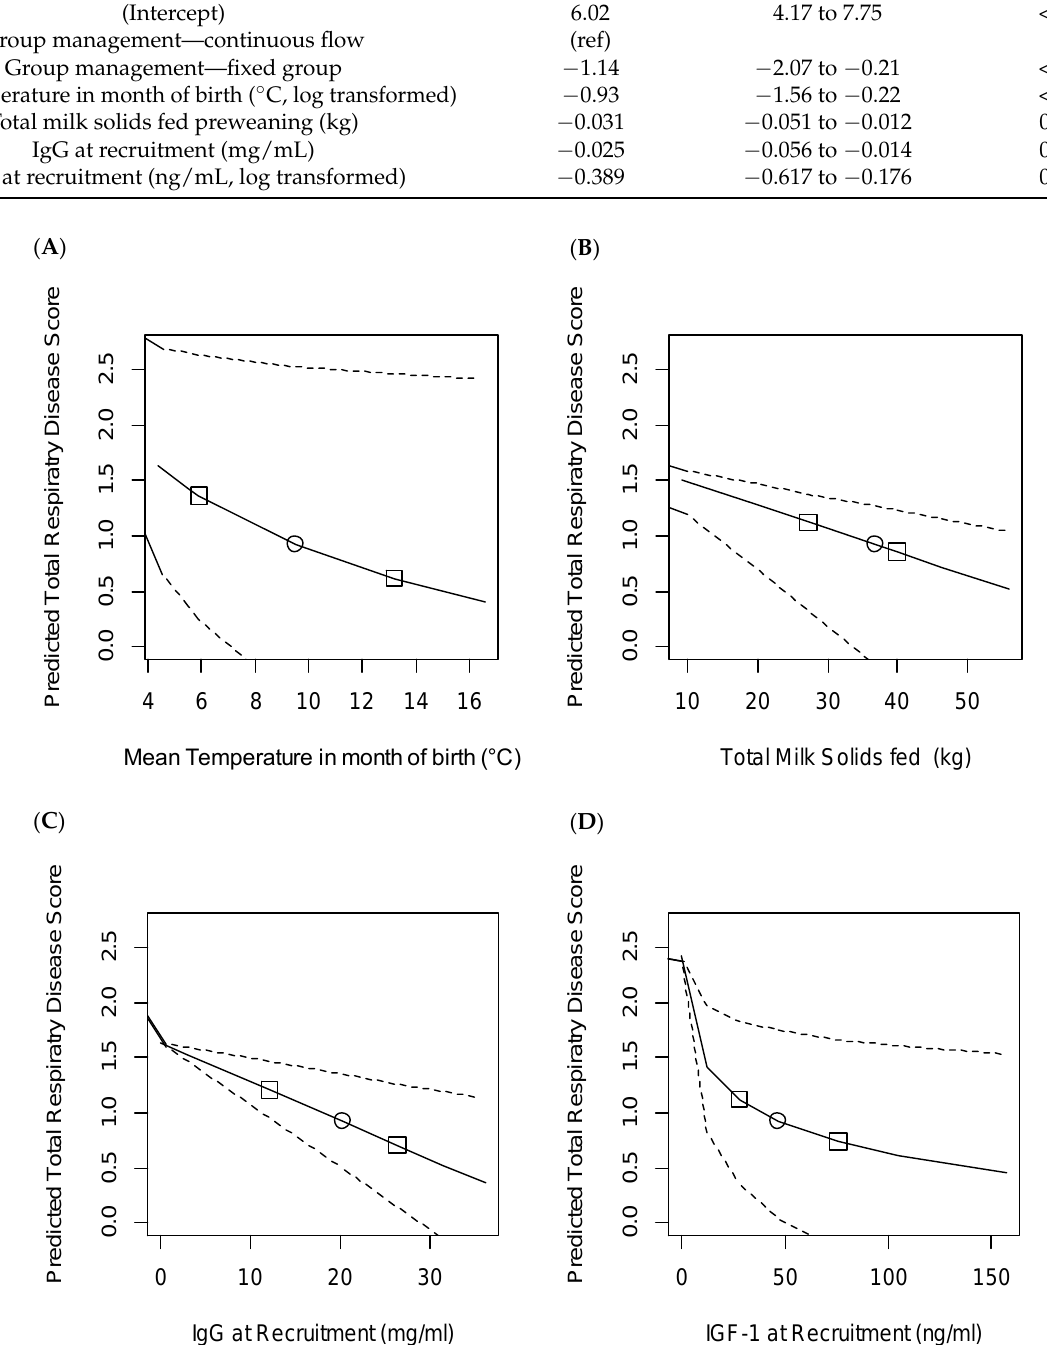
Figure 4. Predicted composite bovine respiratory disease (BRD) score above the threshold for diagnosis in the first nine weeks of life based on variation in: ( A ) mean temperature in the month of birth; ( B ) total milk solids fed preweaning (kg); ( C ) IgG at recruitment (mg/mL) and ( D ) IGF-1 at recruitment (ng/mL). The study included 492 heifers recruited from 11 farms. The predicted score was calculated using the generalised mixed model output described in Table 4. For each figure median values of all the other variables were assumed and were: mean temperature, 9.5 ◦ C; total milk solids fed, 36.8 kg; IgG at recruitment, 20.2 mg/mL; IGF-1 at recruitment, 47.1 ng/mL. Effect estimates were then calculated based on varying only the variable of interest from the first to the 99th percentile. Dashed lines show 95% confidence intervals,